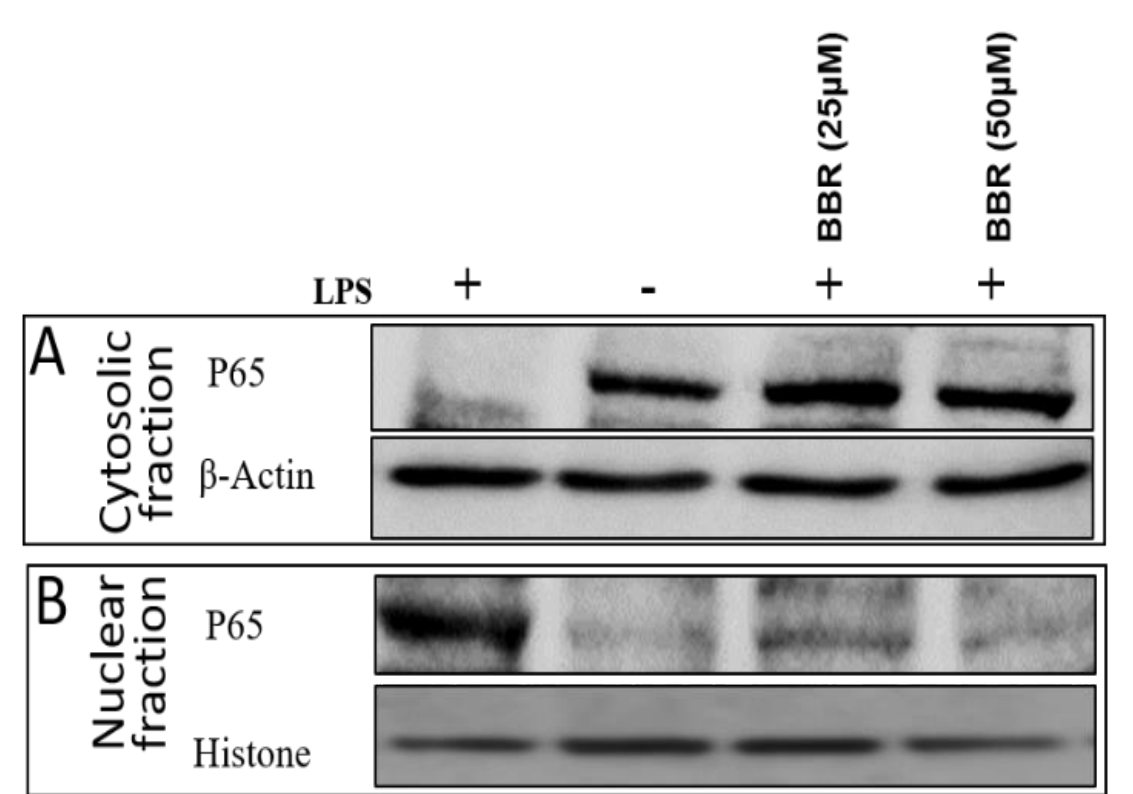
Figure 6. Effect of BBR on LPS-induced NF- κ B P-65 subunit translocation. THP-1 cells were pretreated with BBR, then induced with LPS (0.5 µ g/mL) and protein lysate of cytosol ( A ) and nuclear extracts ( B ) was extracted using NE-PER buffer. Lysates were loaded onto 10% SDS PAGE and transferred to blotting membrane, probed with primary antibody of NF- κ B P-65. Finally, NF- κ B levels were detected by ECL reagents using VersaDoc. For loading controls, antibodies against GAPDH ( A ) and histone ( B ) were used for cytosolic and nuclear fractions, respectively.